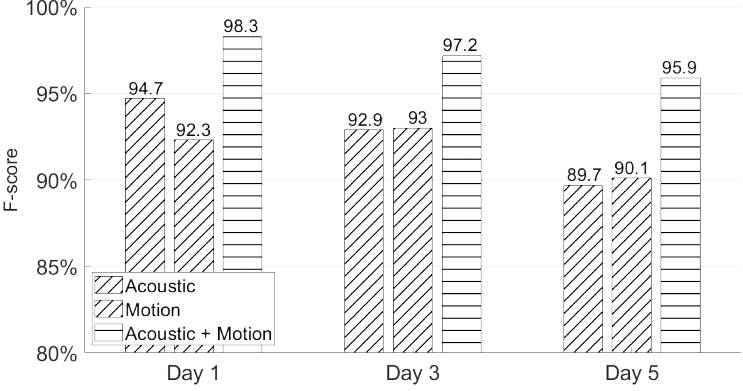
Figure 15. Different days’ authentication